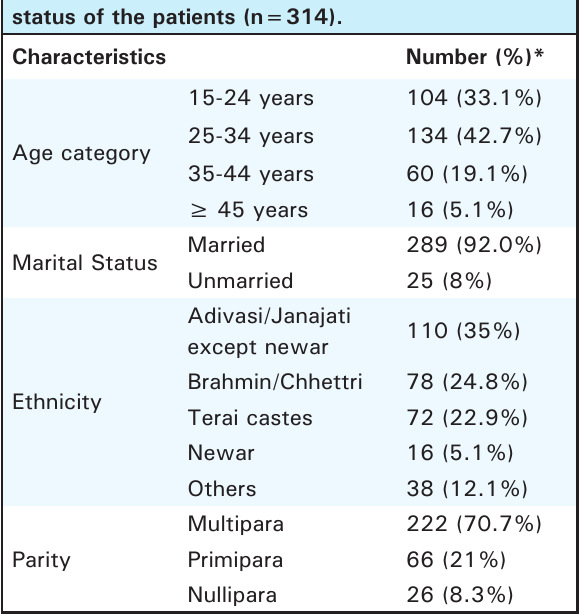
Table 1. Age, marital status, ethnicity and parity status of the patients (n=314).